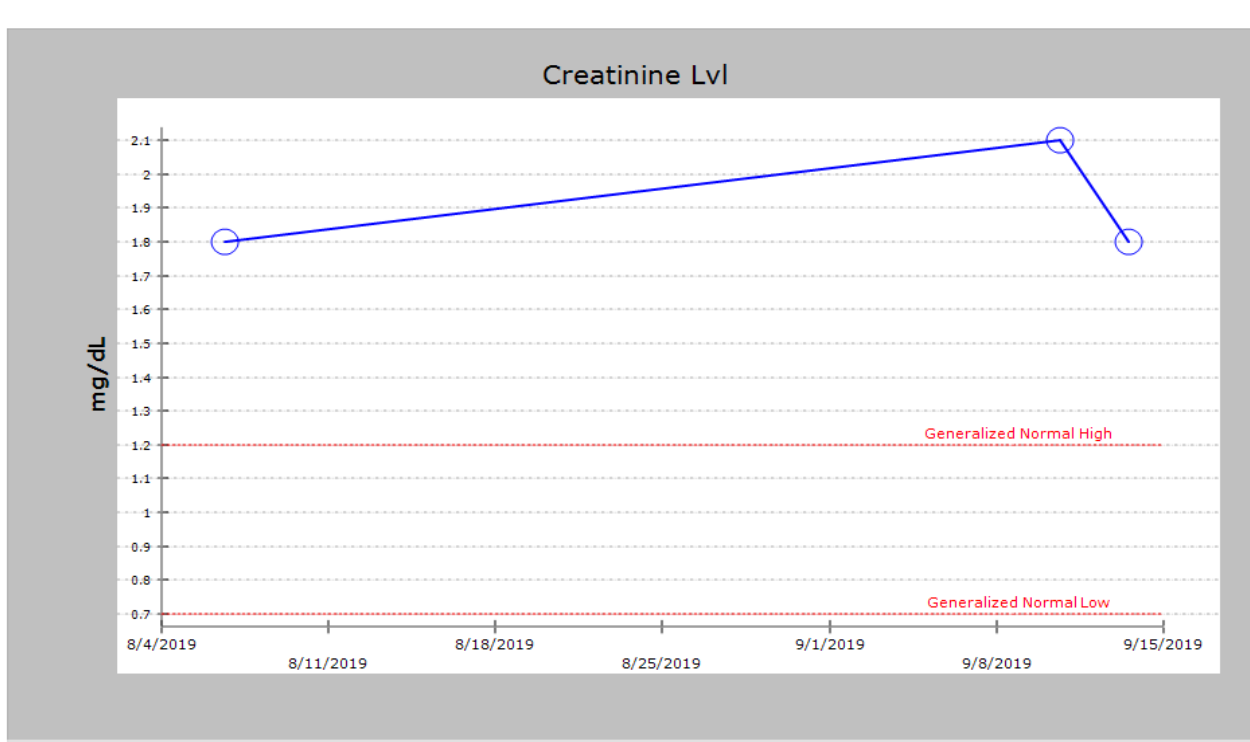
Figure 6. Graphical trend of